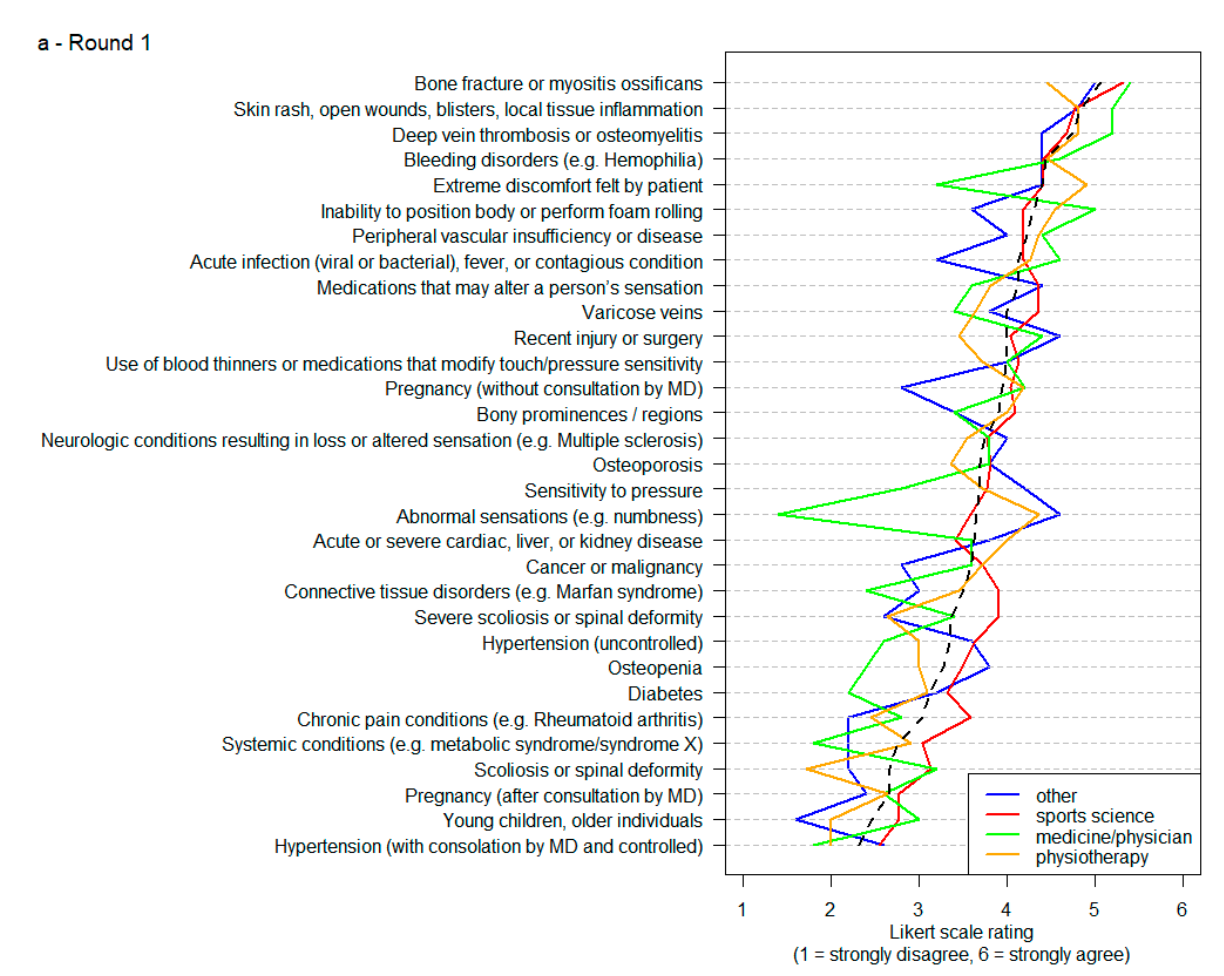
Figure 7. Arguments against dropping of items after Delphi process round 2.